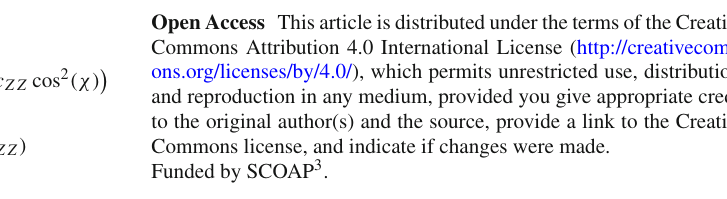
Table 2 Location dependence of the independent components of c μν